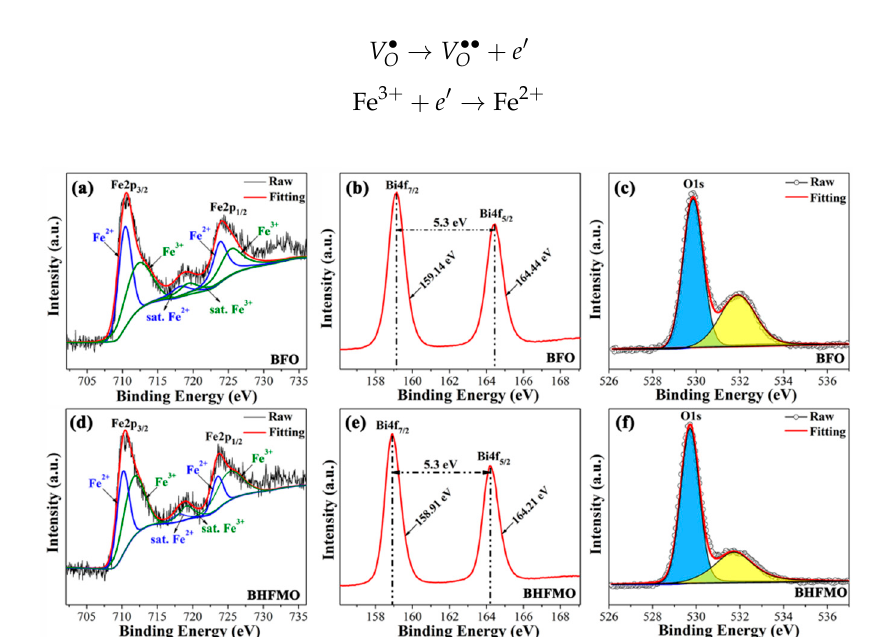
Figure 6. The X-ray photoelectron spectrometer (XPS) spectra of ( a ) Fe2p; ( b ) Bi4f and ( c ) O1s for the pure BFO thin film; XPS spectra of ( d ) Fe2p; ( e ) Bi4f and ( f ) O1s for the BHFMO thin film.